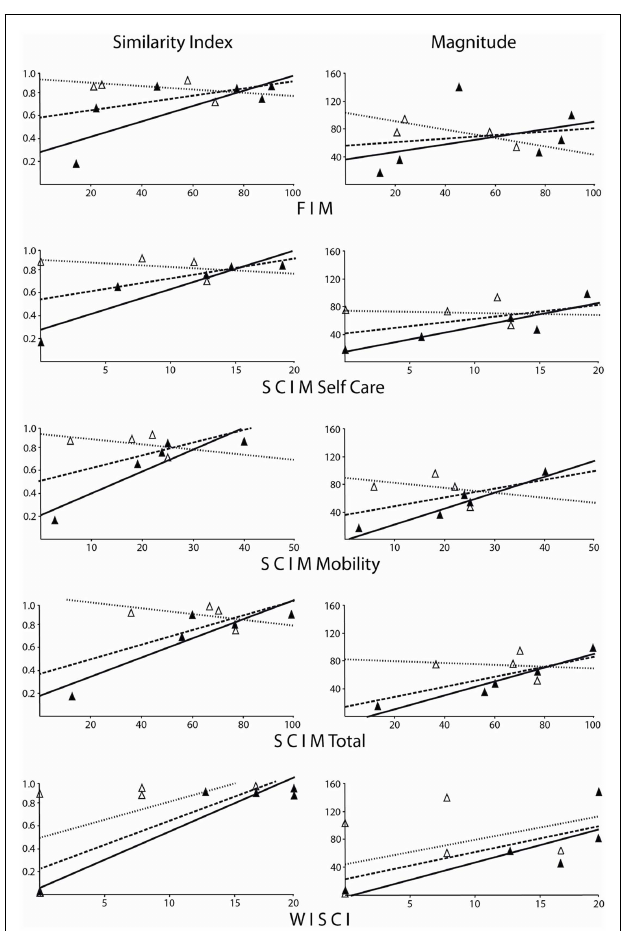
FIGURE 3 | Similarity and magnitude values corresponding to functional scale scores for FIM, SCIM, andWISCI examinations . Open triangles are for early assessment post-injury and filled triangles are for late examinations. Linear trend lines are shown for overall (dashed), early (dotted), and late groupings (solid). Spearman’s correlation coefficients can be found in Table 4 . For the overall, early and late combined grouping, only WISCI scale scores significantly correlated with neurophysiological parameters. SI and Mag values from late examination groupings correlated well with function scale values, reaching significance for SCIM andWISCI